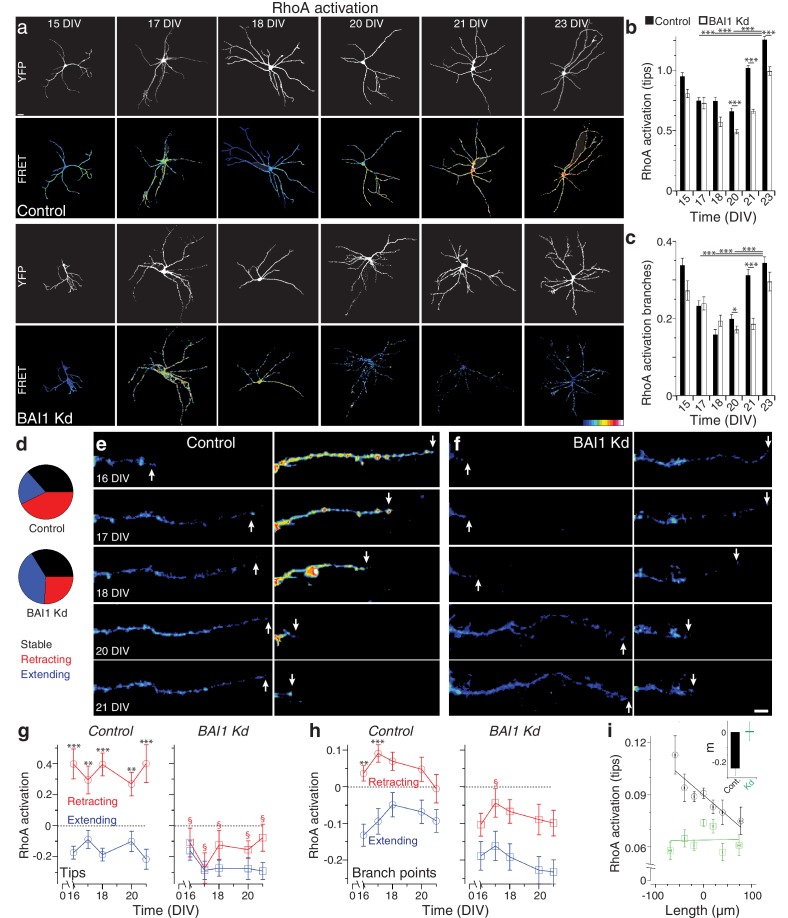
BAI1 drives a late dendritic RhoA activation peak and ties RhoA activation to dendrite behavior.(a) Representative images of hippocampal neurons expressing Raichu-RhoA alone (control) or with shRNAs against Adgrb1 (BAI1 Kd) measured at the indicated times. Overall dendrite structure was ascertained by directly exciting the FRET acceptor (YFP images), while relative RhoA activation is shown in the FRET images according to the color code in the lower right corner (low values on the left, high on the right). Images are masked to remove axons and dendrites from other neurons. Bar is 20 µm. (b) Summary data of RhoA activation at dendrite tips. (c) Summary data of RhoA activation at dendrite branch points. Total number of neurons: 49 (15 DIV, control), 27 (15 DIV, BAI1 Kd), 34 (17 DIV, control), 20 (17 DIV, BAI1 Kd), 35 (18 DIV, control), 34 (18 DIV, BAI1 Kd), 36 (20 DIV, control), 38 (20 DIV, BAI1 Kd), 37 (21 DIV, control), 32 (21 DIV, BAI1 Kd), 53 (23 DIV, control), and 31 (23 DIV, BAI1 Kd) (N = 5). (d) Pie charts showing the behavior of hippocampal dendrites persistent from 16 to 21 DIV in Control and BAI1 Kd neurons. Throughout this figure, stable dendrites are shown in black, retracting dendrites in red, and extending dendrites in blue. e and f Representative longitudinal images of extending (left) and retracting (right) dendrites in Control (e) and BAI1 Kd (f) neurons expressing the RhoA-FLARE reporter. The color scale for RhoA activation is the same as in panel A. Arrows track dendrite tip location. Images are masked to remove axons and dendrites from other neurons. Bar is 10 µm. (g) Summary of RhoA activation levels at dendrite tips in control (left) and BAI1 Kd (right) neurons through time. RhoA activation levels in stable neurons were also stable and assigned a value of 0 throughout the time course. All data were scaled to the average value of FRET in control somata on 16 DIV for the appropriate repeat of the experiment. (h) Same as panel g, but for dendrite branch points. (i) RhoA activation levels from all dendrites (stable, retracting, and extending) were pooled and plotted against day-long changes in dendritic length in control (black) and BAI1 Kd (green) neurons and linear fits were applied as shown. The inset to this panel shows the slopes extracted from these linear fits. Total number of dendrites represented in panels e-h, 922 for control (from 50 neurons) and 821 for BAI1 Kd (from 38 neurons) (N = 5). Data are represented as mean ± s.e.m., except for the inset to panel i, which is shown ± 95% confidence intervals. (***p<0.0001, **p<0.01, *p<0.05; §p<1e-6 vs. control retracting) Detailed statistics are found in Figure 3—source data 1.10.7554/eLife.47566.028Figure 3—source data 1.Statistical summary for Figure 3: ANOVA and key Tukey post-hoc tests and N and n values for Figure 3b,c,g,h.10.7554/eLife.47566.024Figure 3—source data 2.Individual values for RhoA activation and related values over fixed and longitudinal time courses (Figure 3b,c,g–i).10.7554/eLife.47566.025Figure 3—source data 3.Individual measurements for long-term Rho-GTPase measurements in Cos-7 cells (Figure 3—figure supplement 1b,d,f,h,j,k).10.7554/eLife.47566.026Figure 3—source data 4.Individual measurements of Rac1 and correlations between RhoA activation and growth (Figure 3—figure supplement 2b,c,e–g).10.7554/eLife.47566.027Figure 3—source data 5.Individual measurements of arbor parameters in control and RhoA KO mouse neurons (Figure 3—figure supplement 3b–e).